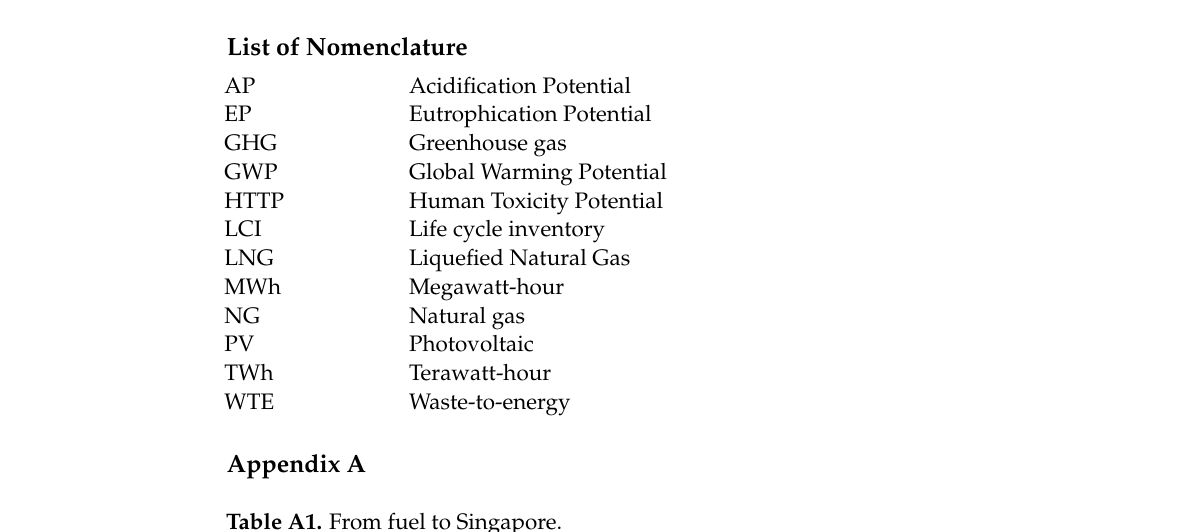
Table A1. From fuel to Singapore.